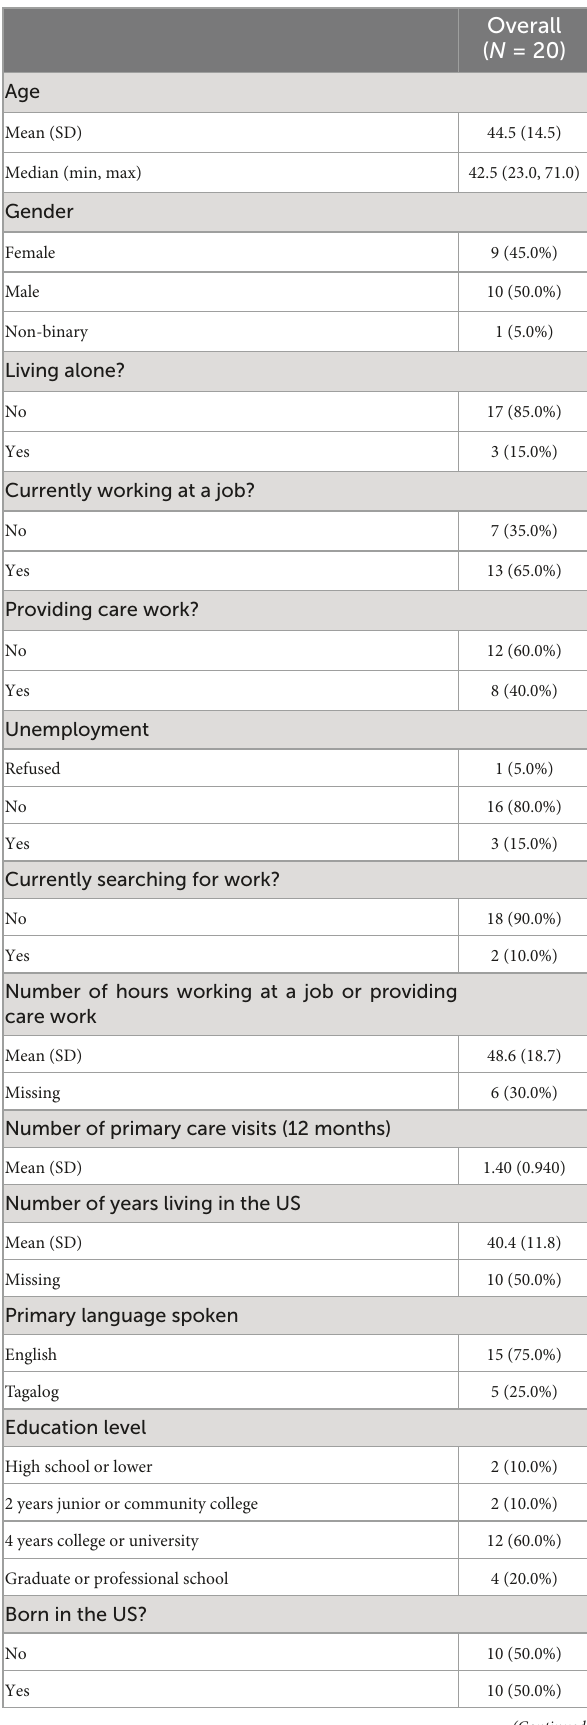
TABLE 1 Sociodemographic characteristics of